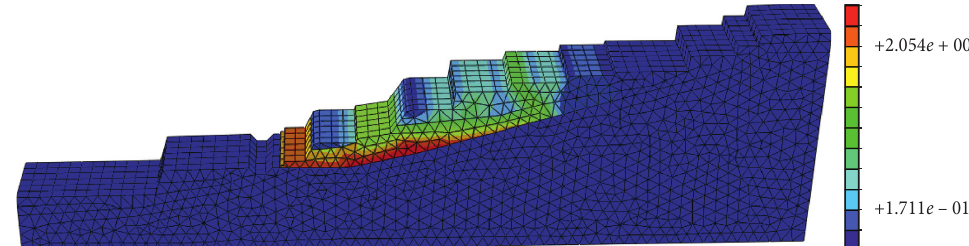
Figure 12: The total equivalent plastic strain contours under critical damage condition.